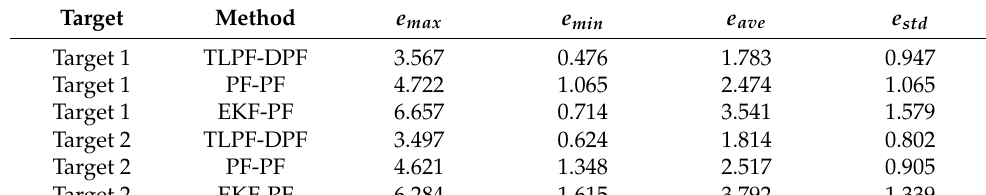
Table 2. Comparison of positioning errors with Gaussian mixture noise.